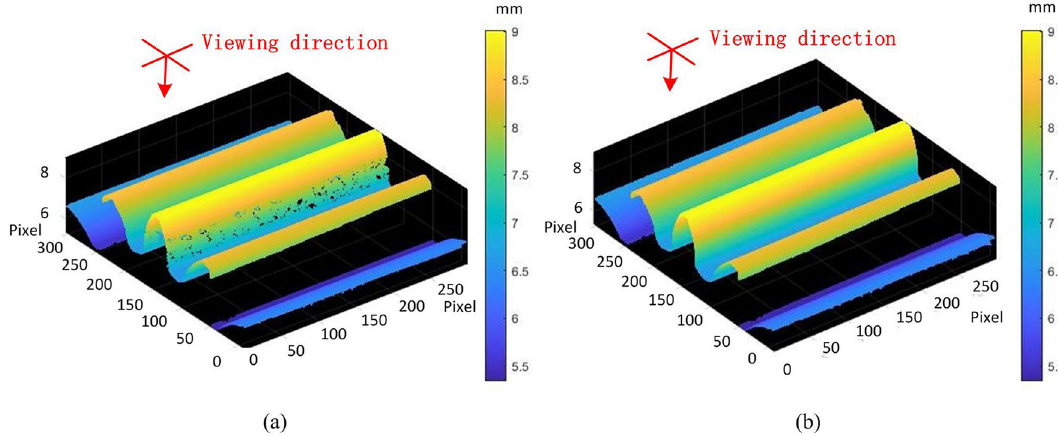
Figure 7. The comparison between the reconstructed gear teeth ( a ) with traditional four-step PSP and the reconstructed gear teeth ( b ) with proposed method.